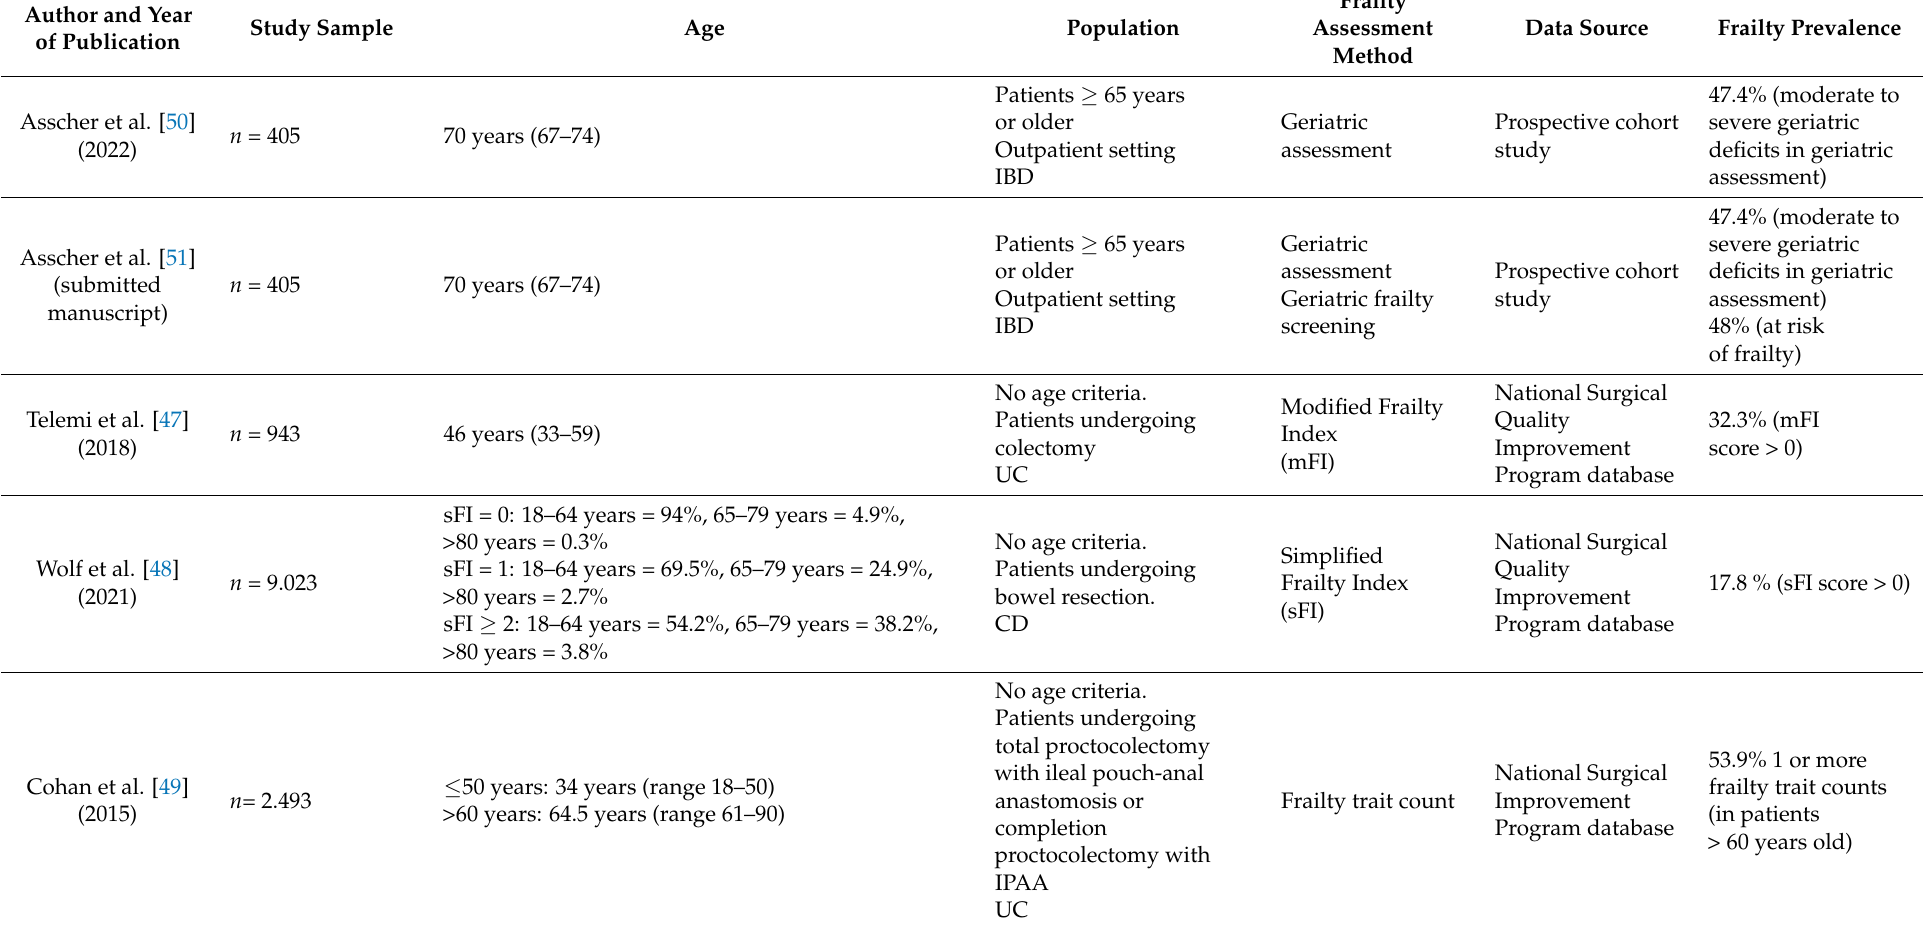
Table 2. Study characteristics, frailty measurement methods and frailty